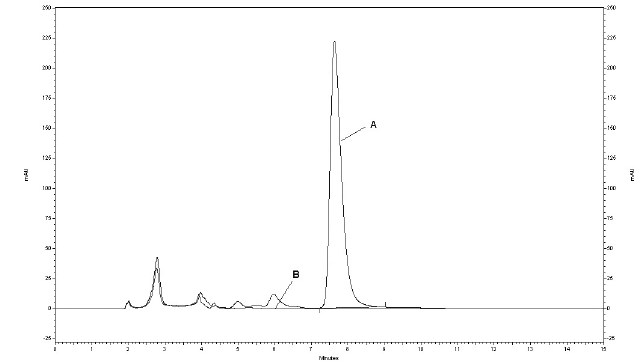
FIGURE 3 - Graph Area versus formation and decomposition Time of apramycin-OPA derivative with different OPA:apramycin concentration ratios.